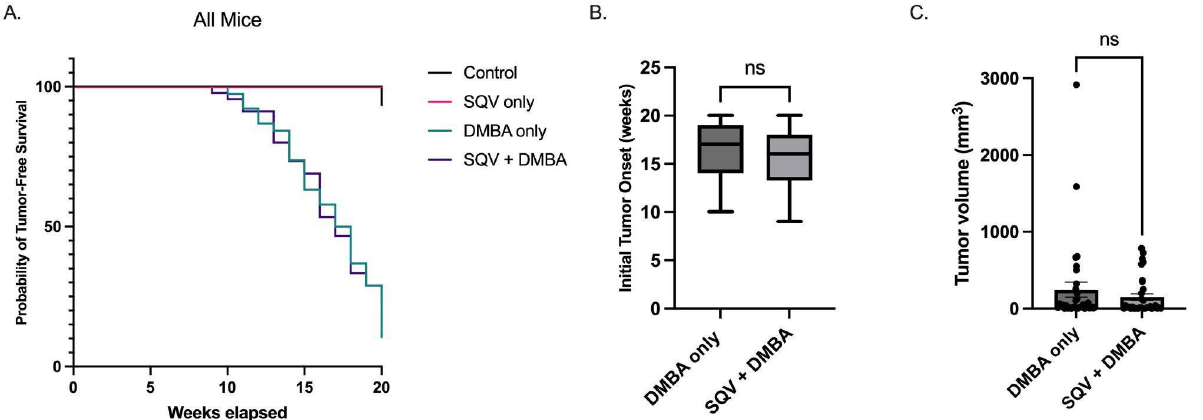
Figure 2. Tumor-free survival, tumor volume, and tumor onset: ( A ) Tumor-free survival and tumor volume over the 20-week treatment period; ( B ) Average initial tumor onset (in weeks) for mice that developed overt anal tumors during the treatment period; ( C ) Final tumor volume measured prior to sacrifice for mice that developed tumors within 20 weeks. In ( B , C ), “ns” is not